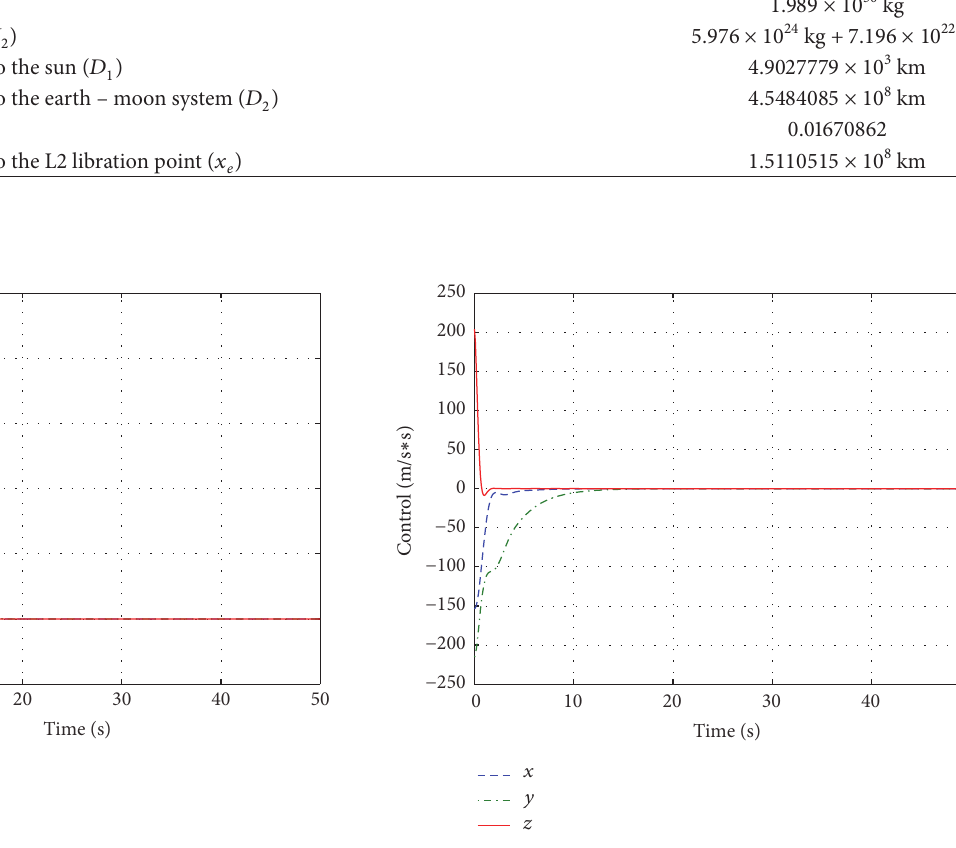
Figure 3: Position error variation curve of SDRE.